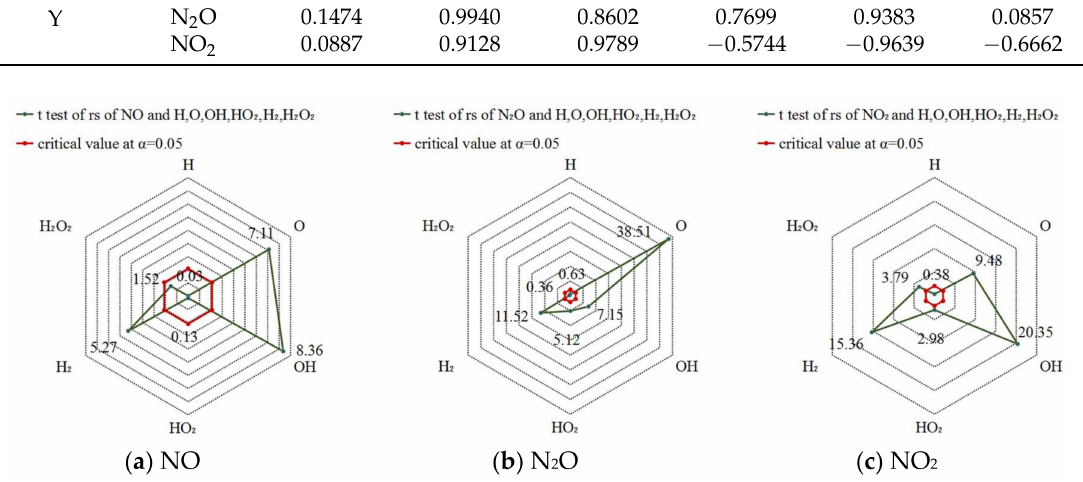
Figure 8. Result of Student’s t significance test for SRCC (confidence level α =